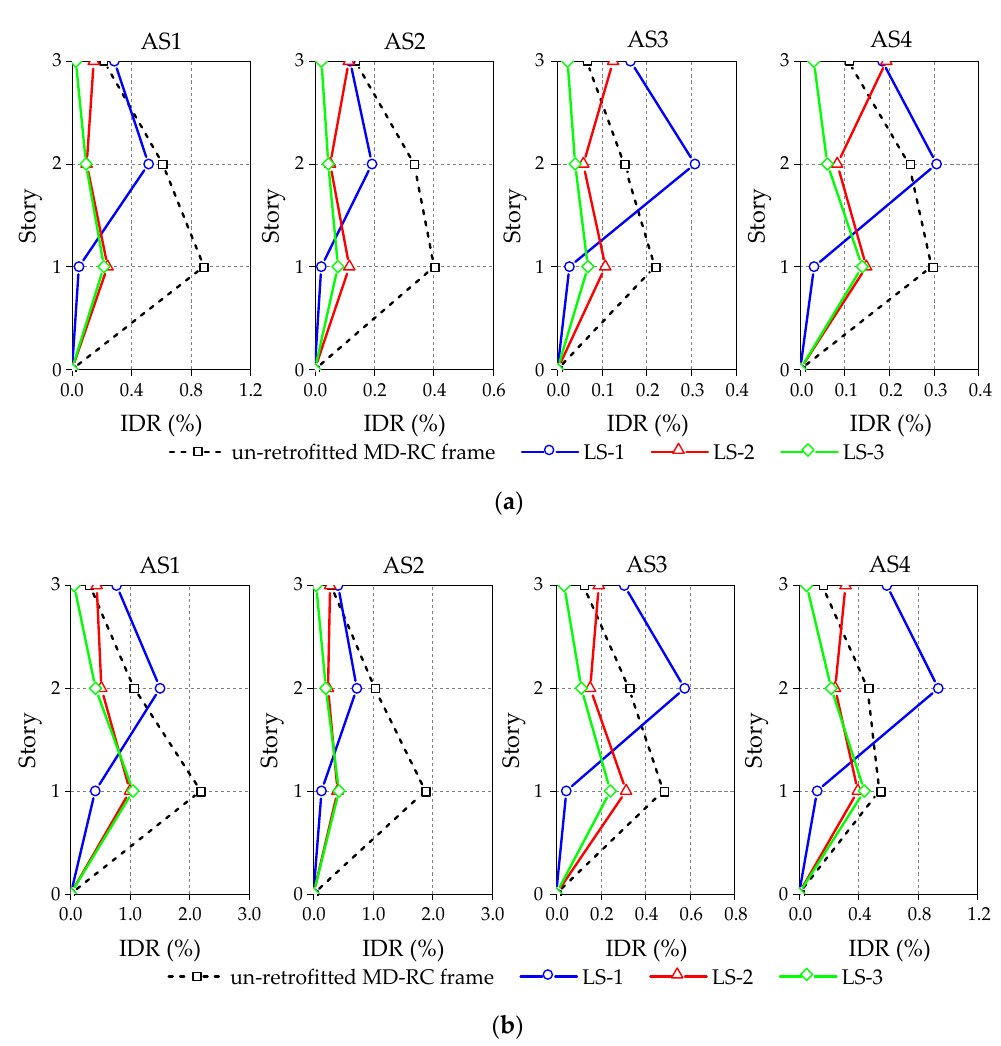
Figure 13. IDR distribution of MS2 MD ‐ RC frame with DS1 ( a ) and DS2 ( b ) damage state before and after retrofitting. Table 8. Maximum IDR and shock absorption rate (SAR) of MD ‐ RC frame before and after retrofitting. Aftershocks